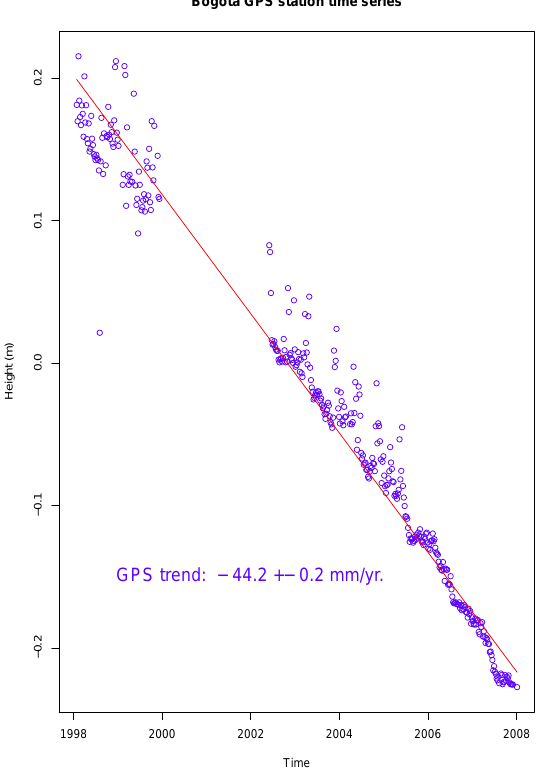
Fig. 11. GPS station Bogot`a (BOGT) exhibits a significant secular Fig.13. Subsidence of the IGACbuilding, on which the GPSstation islocated, results ina massive secular trend of -44.2 ± 0.2mm/yr at Bogot`aGPSstation. height trend of − 44 . 2 ± 0 . 2mmyr − 1 .